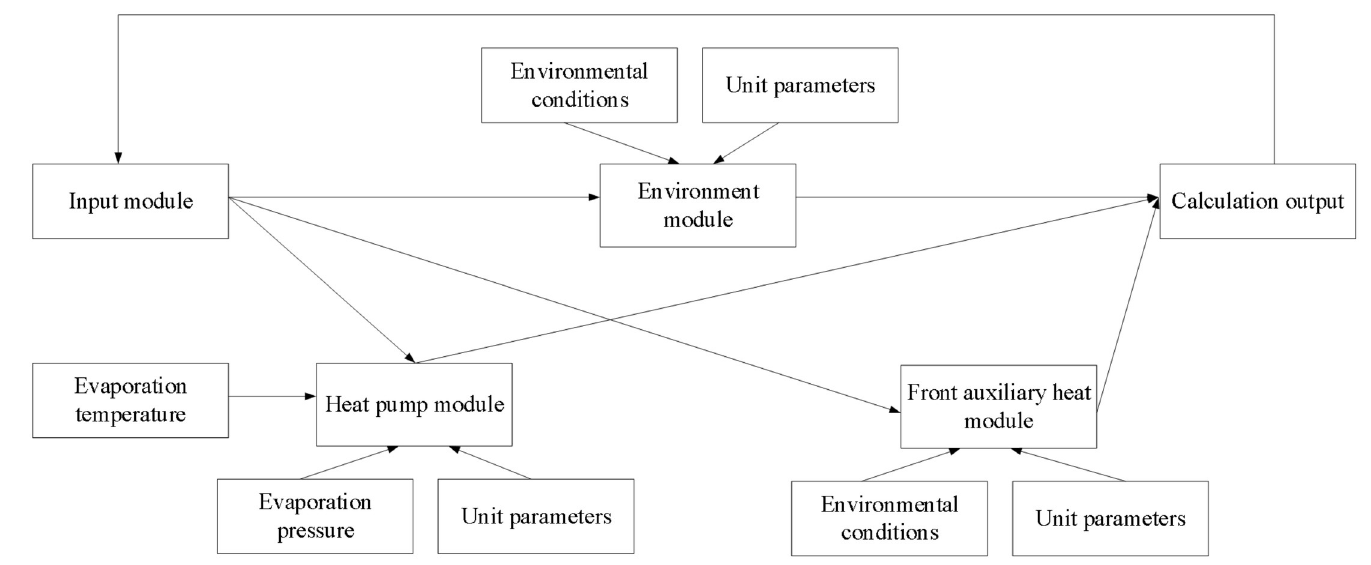
Fig 3. A simulation model of defrost heat pump